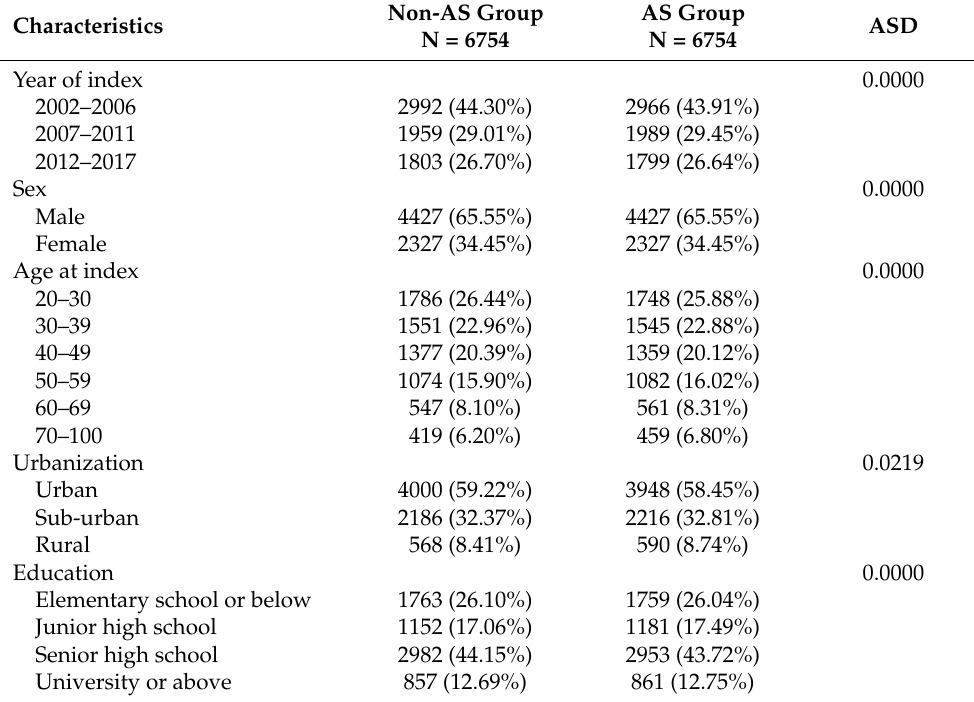
Table 1. Baseline characteristics between the two